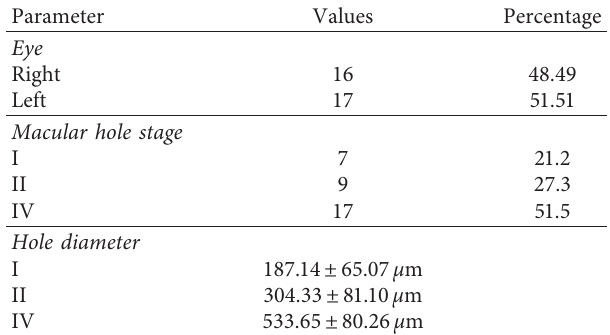
Table 2: Preoperative and postoperative best-corrected visual